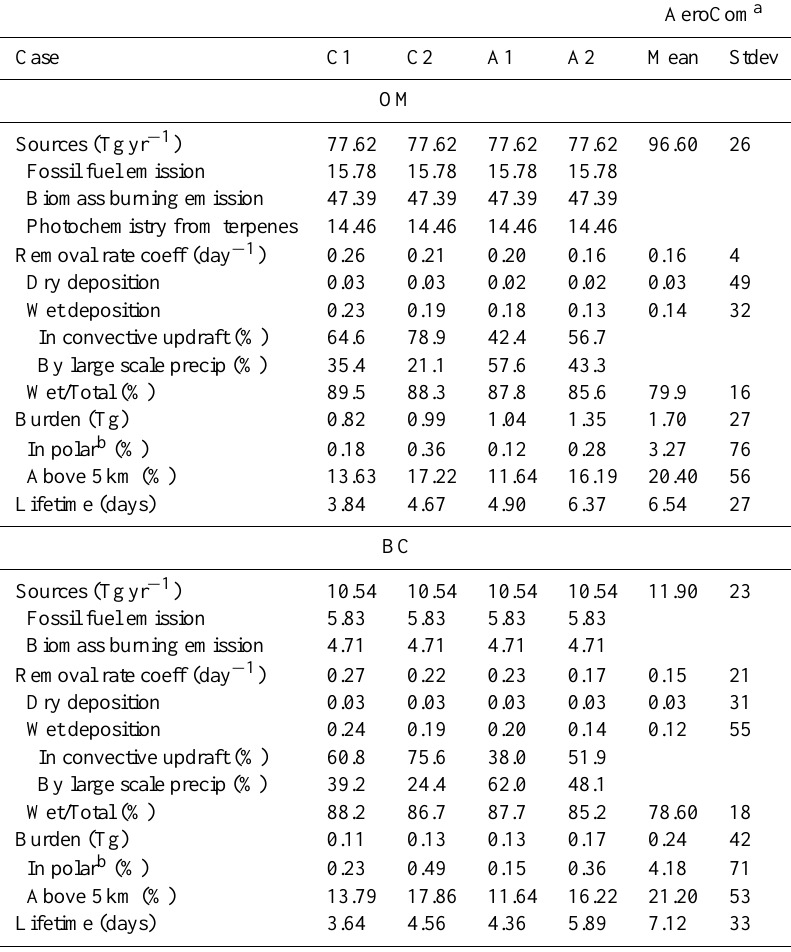
Table 5. Global budget of OM and